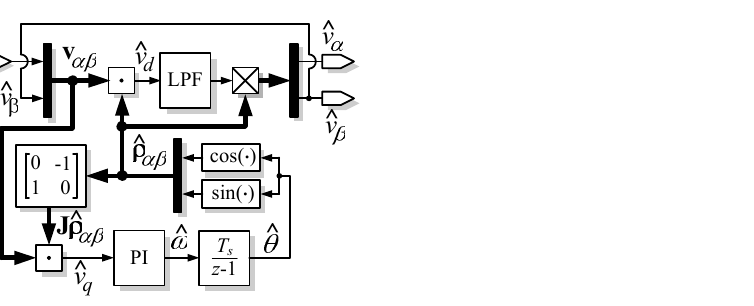
Figure 5. Block diagram of the single-phase Synchronous Reference Frame (SRF)-based PLL scheme. Table 1. Harmonic contents of the reference signal v α as % of the fundamental component. No. Harm